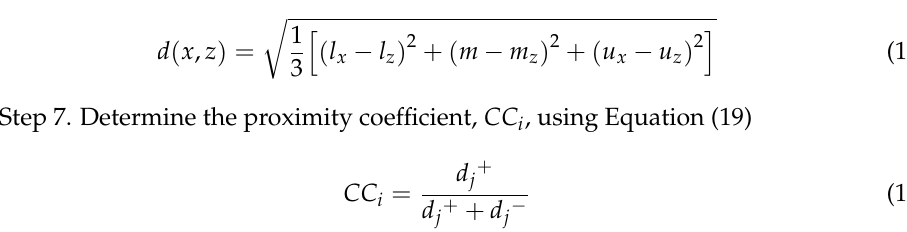
Table 2. Pair-wise comparison scale for AHP